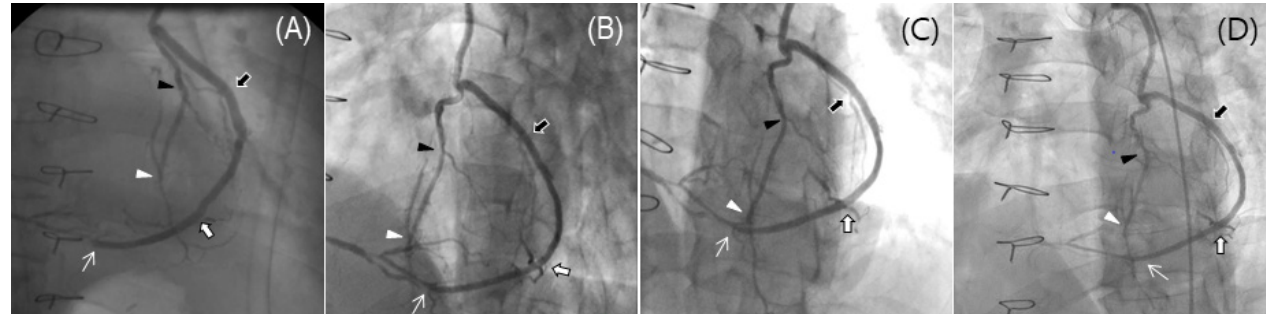
Fig. 1 - Patent no-touch saphenous vein (SV) Y-composite grafts based on the in situ left internal thoracic artery (ITA) at (A) early postoperative, (B) 1-year, (C) 5-year, and (D) 10-year angiographies in a 54-year-old male patient enrolled in the SAVE RITA trial. The in situ left ITA was anastomosed to the second diagonal (black arrowheads) and left anterior descending coronary arteries (white arrowheads), and the SV was anastomosed to the first diagonal (black arrows) and distal obtuse marginal (white arrows) and right posterolateral coronary arteries (white thin arrows) using a sequential anastomotic technique. SAVE RITA=SAphenous VEin versus Right Internal Thoracic Artery as a Y-Composite Graft